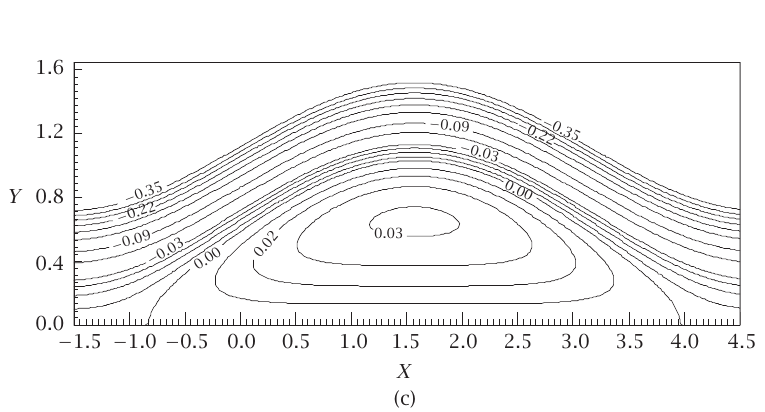
Figure 6.7 . The streamlines for M = 2, ϕ = 0 . 4, δ = 0 . 06, θ ( 2 ) = 0 . 8, and Re = 1, at (a) K = 0 . 02, (b) K = 0 . 08, and (c) K = 0 .